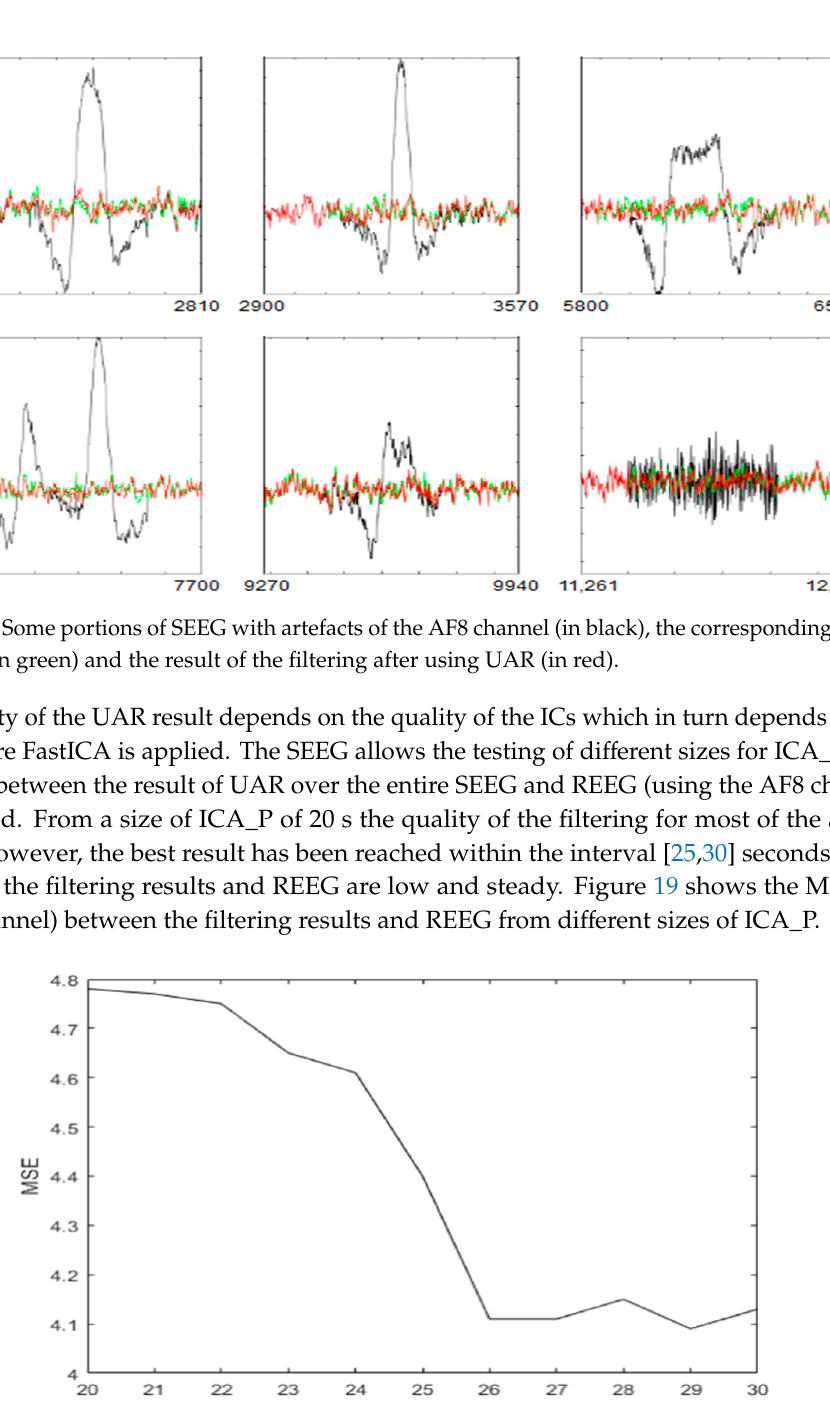
Figure 19. The mean squared errors ( MSE s) (for the entire AF 8 channel) between the filtering results and REEG from different sizes of ICA_P .